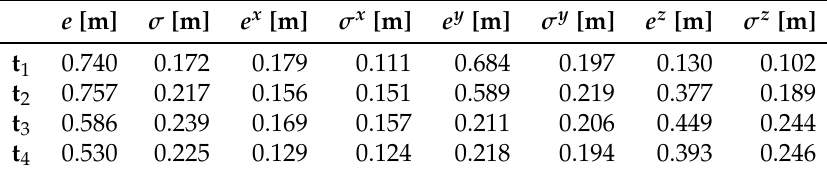
Table 1. Experimental results in Configuration 1: measured average errors ( e , e x , e y , and e z ) are shown together with the relative standard deviations ( σ , σ x , σ y , and σ z ) for the four considered positions ( t 1 , t 2 , t 3 , and t 4 ) of the